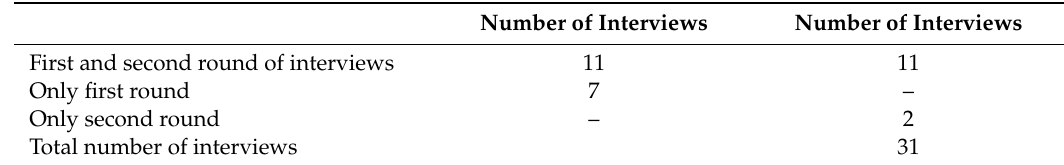
Table 3. Information about Performed